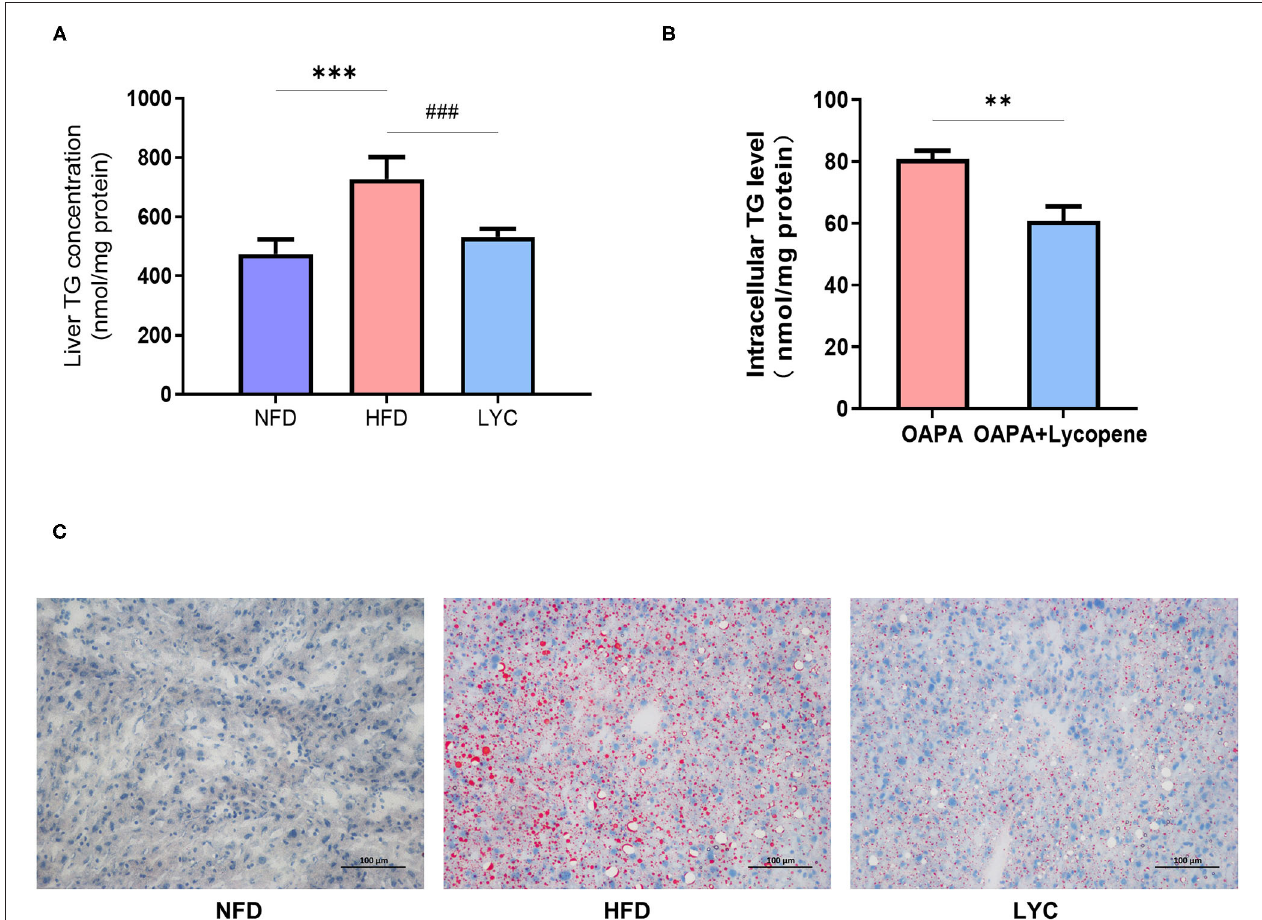
FIGURE 2 | Lycopene alleviates liver fatty deposition induced by HFD. (A) Mouse liver TG level. (B) Oil Red O staining ( × 200 magnification) of the liver in different groups. Scale bar = 100 µ m. (C) HepG2 cell TG level. Data are expressed as the mean ± SD. ** p < 0.01, *** p or ### p < 0.001. NFD, normal fat diet group; HFD, high fat diet group; LYC: lycopene